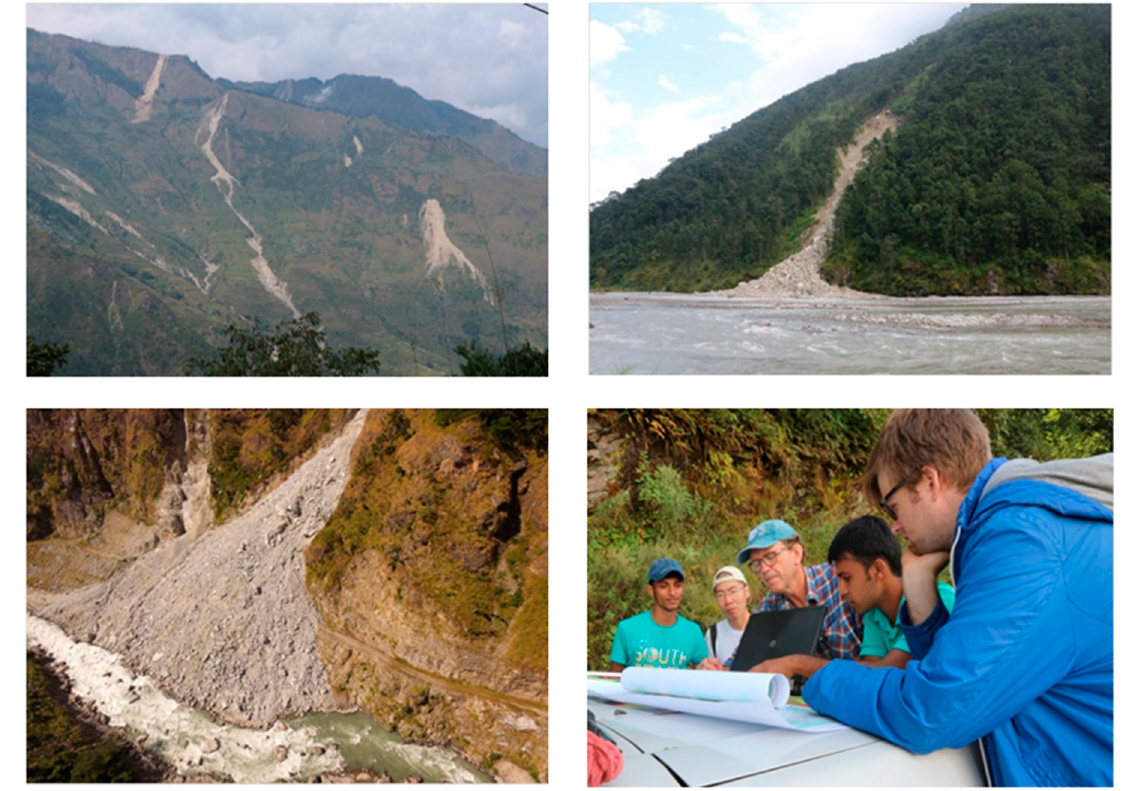
Figure 3. Field photographs showing landslide areas during field survey in the Rasuwa district.